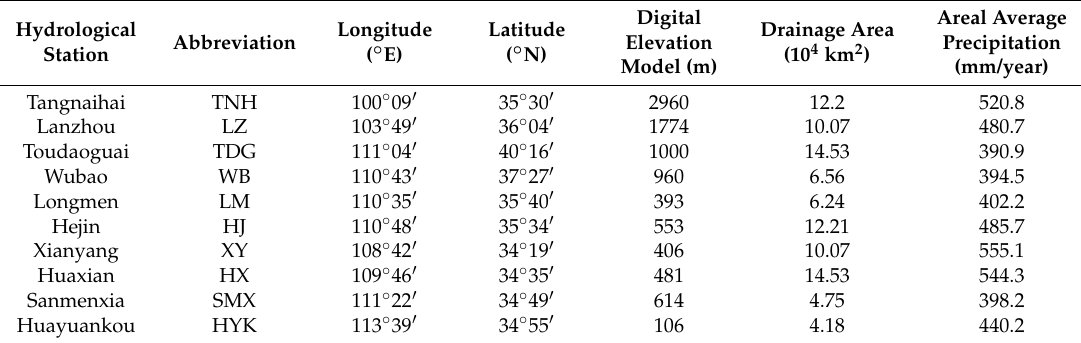
Table 1. Information on the 10 hydrological stations of the Yellow River